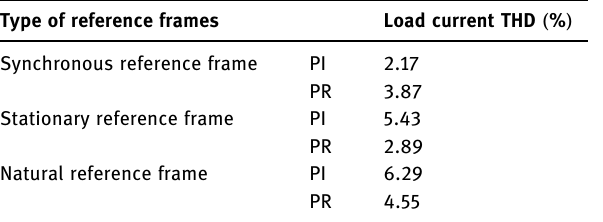
Table 3: Comparison of THD of load current for di ff erent reference